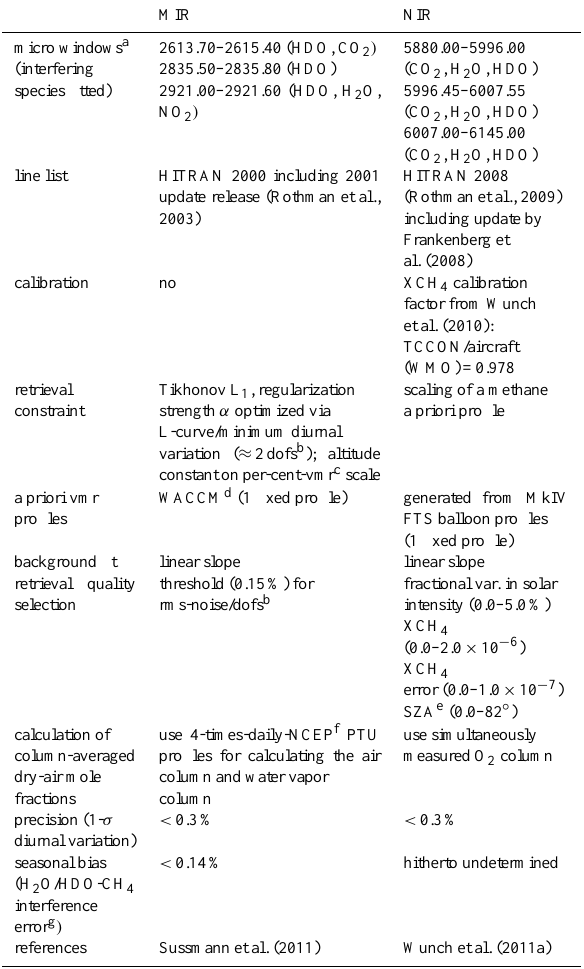
Table 1. Strategies for retrieval of column-averaged methane from MIR and NIR solar